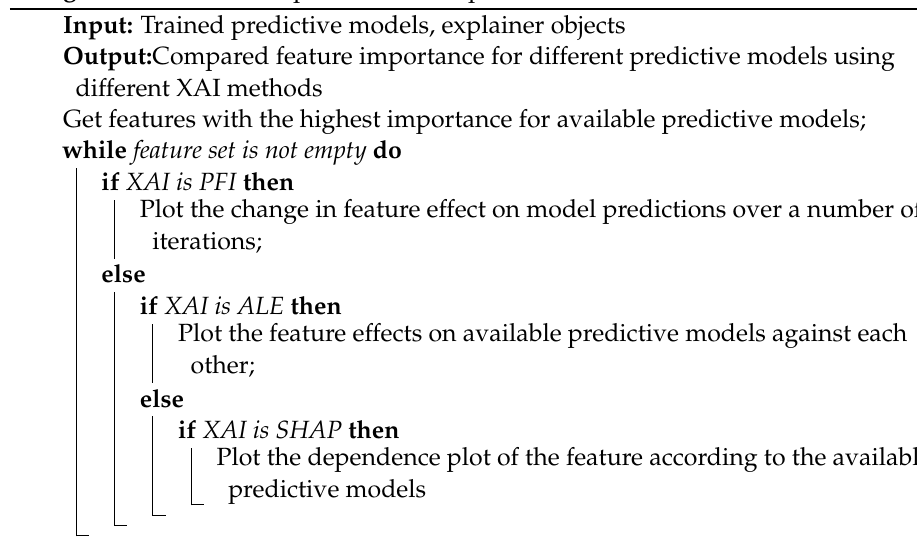
Algorithm 1: Global Explanations